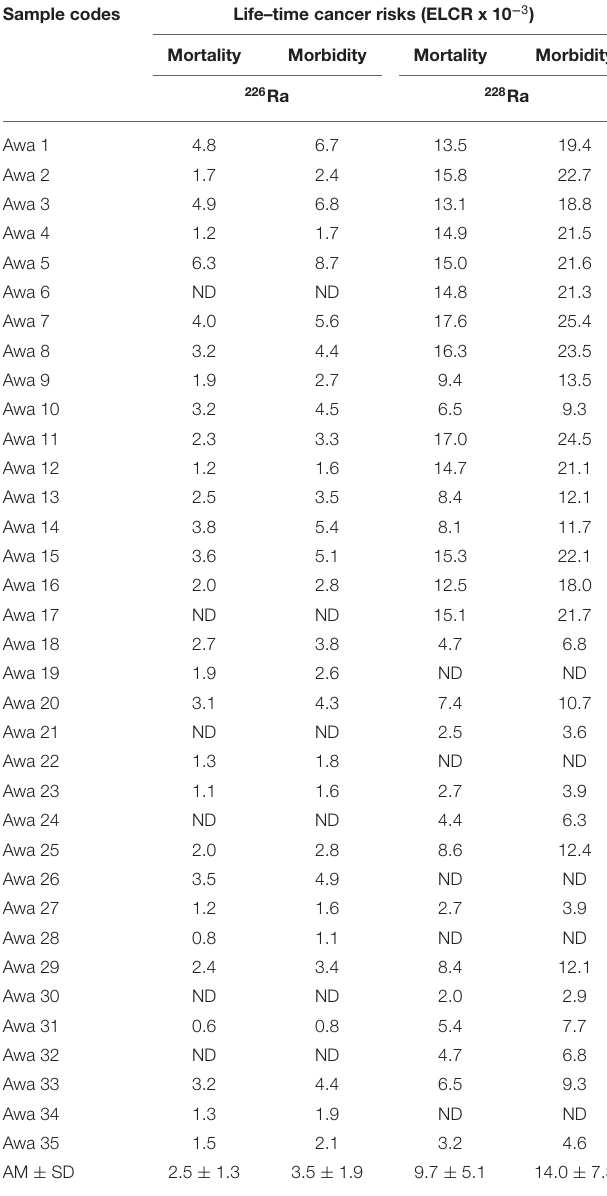
TABLE 4 | Radiological risks of radium isotope 226 Ra and 228 Ra in the sampled sachet water. Sample